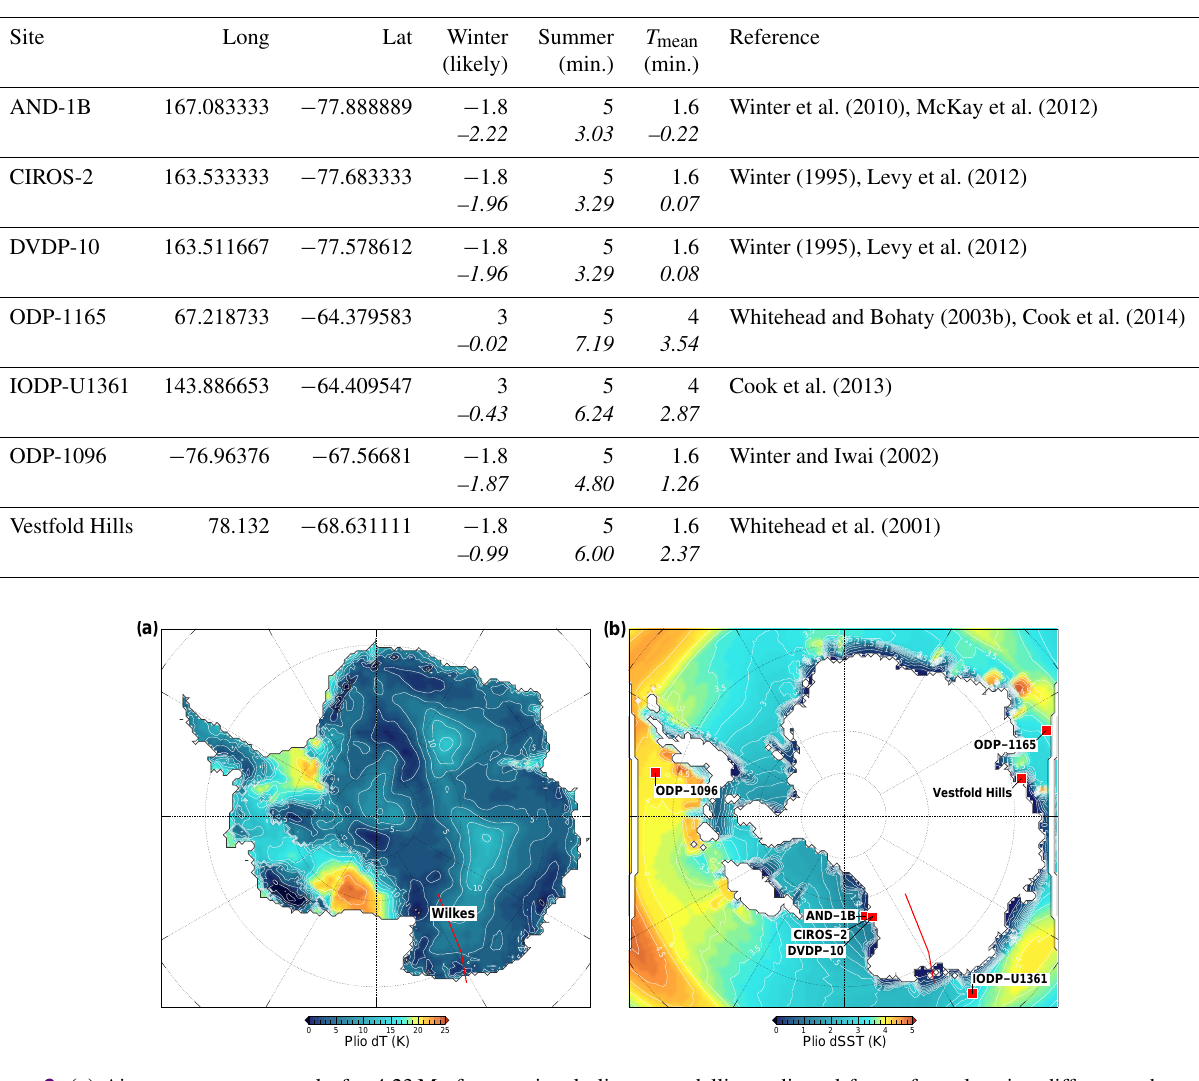
Figure 3. (a) Air temperature anomaly for 4.23Ma from regional climate modelling, adjusted for surface elevation differences between the RCM input orography and the present-day elevations used to initialize the ice-sheet model. Contours show 2.5 ◦ C increments. Biases used in certain simulations are additional to the warming values shown here. (b) As (a) but showing sea-surface temperature anomaly. Contours show 0.25 ◦ C increments. Locations of profile shown in Fig. 7 also shown (red line), as well as the locations (red squares) of the palaeo-environmental proxy data in Table